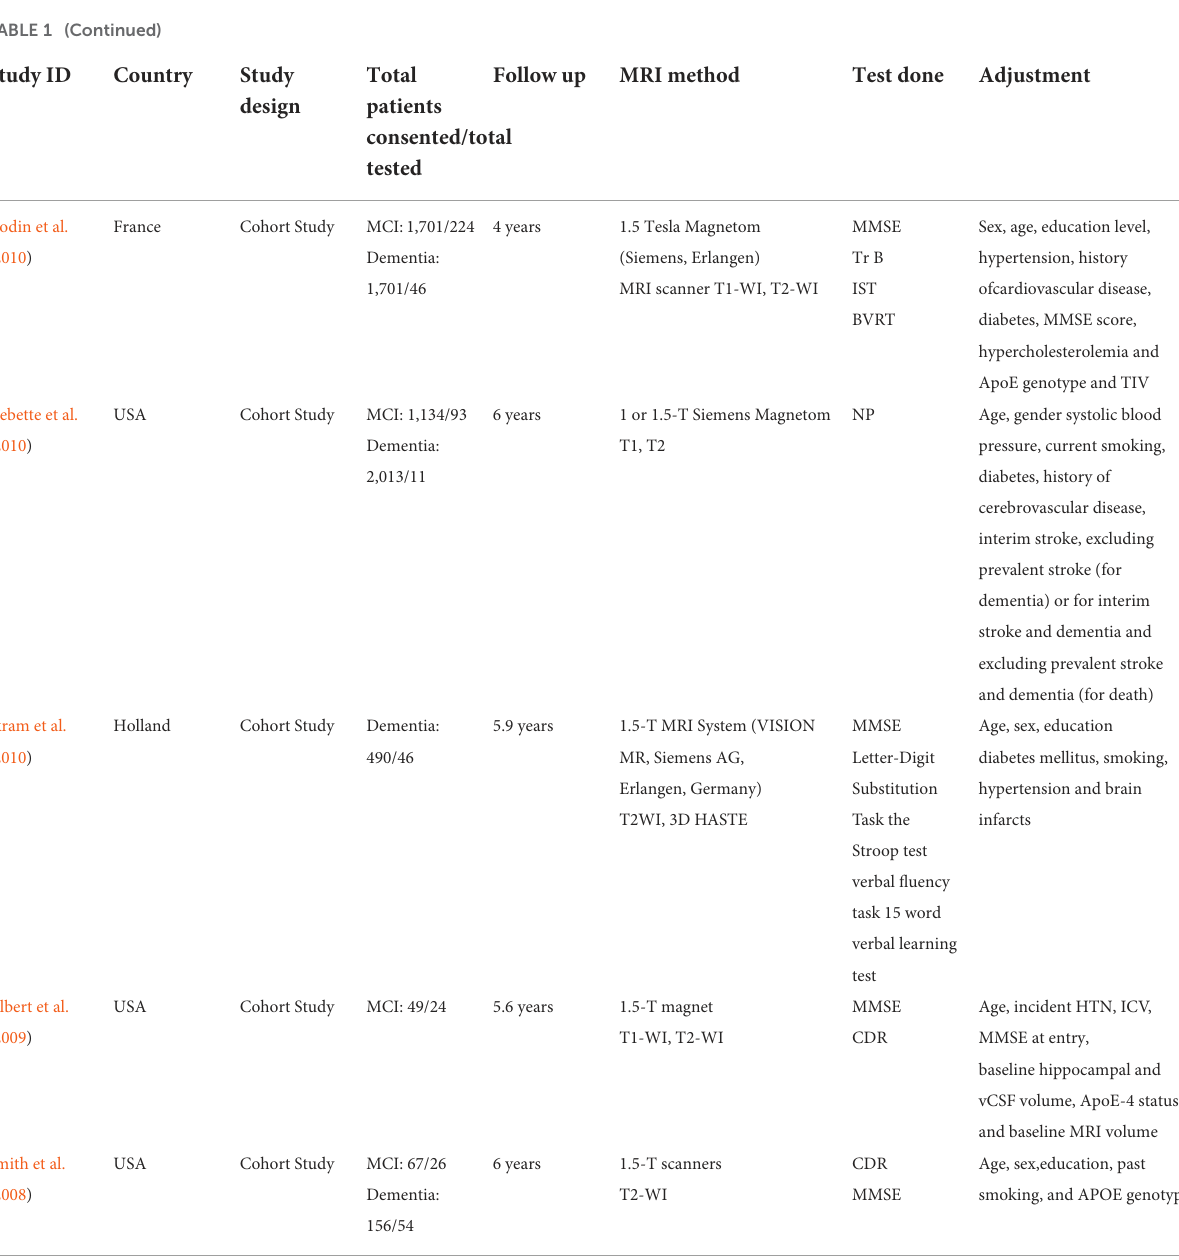
Figure 4]. The result of Egger’s test detected publication bias ( t = 6.94, df = 16, P -value < 0.0001). This was corrected by using the “trim-and-fill” method (Figure 5), and the effect size after simple compliment was RR = 1.0475 (95% CI: